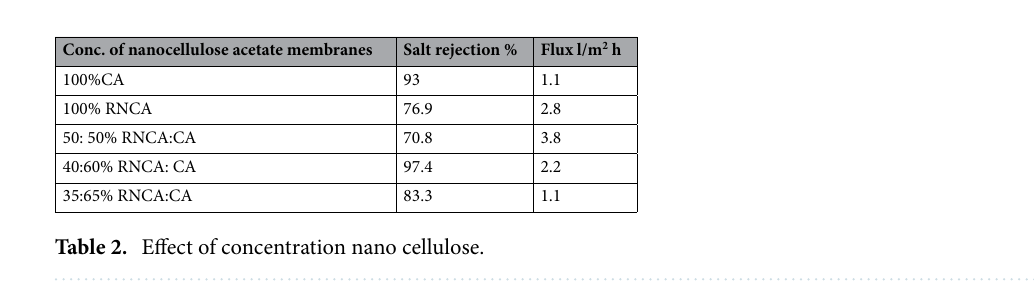
Figure 13. Salt rejection and water flux versus feed pressure of CA-RO membrane with 40% NRCA membrane.